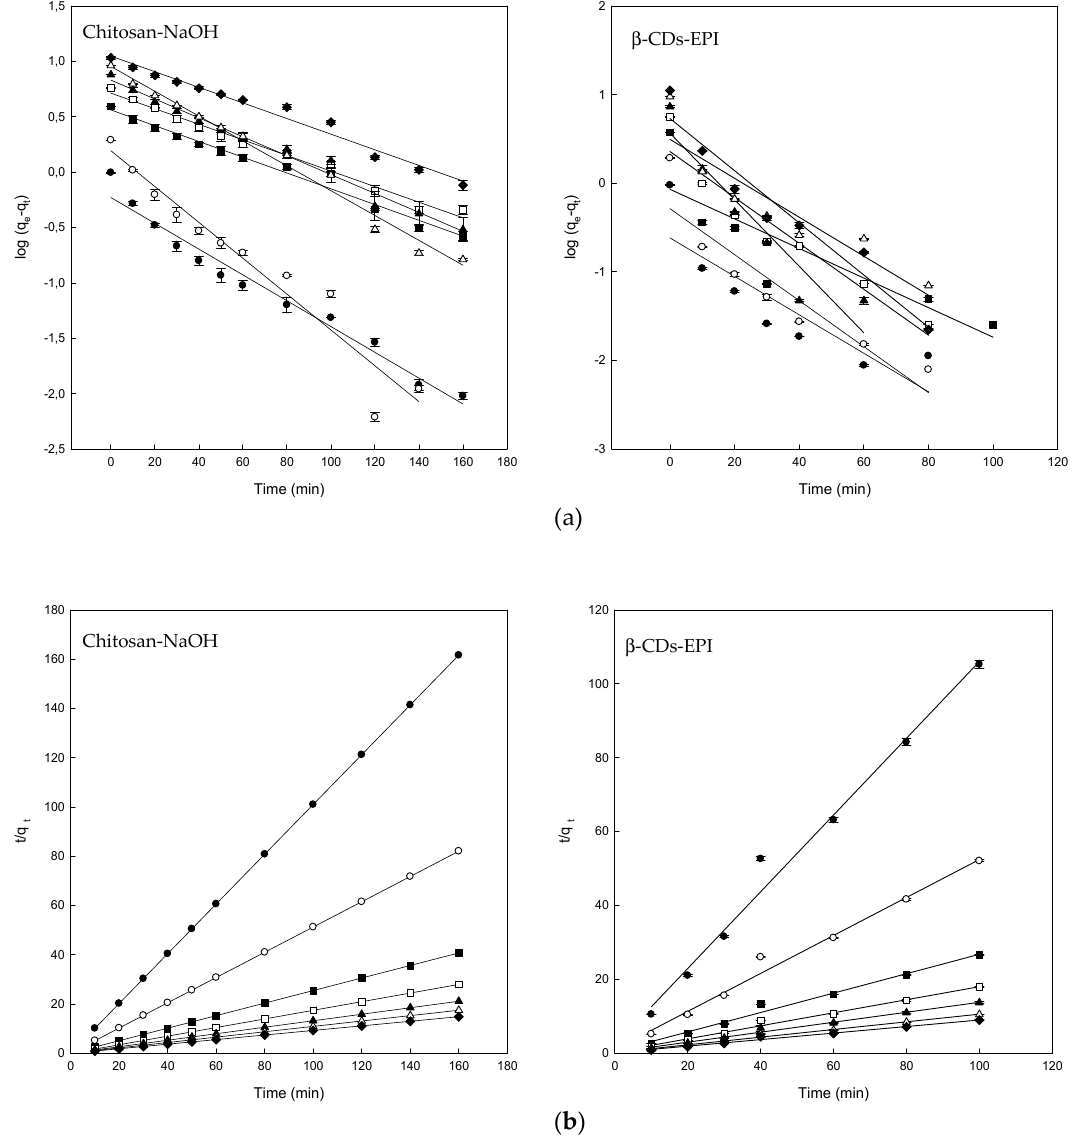
Figure 4. ( a ) The pseudo-first-order model plots and ( b ) pseudo-second-order model plots for the Direct Blue 78 adsorption onto chitosan-NaOH and β -CDs-EPI polymers at di ff erent concentrations of dye 25 mg / L ( (cid:8) ), 50 mg / L ( ), 100 mg / L ( (cid:4) ), 150 mg / L ( (cid:3) ), 200 mg / L ( (cid:78) ), 250 mg / L ( ∆ ) and 300 mg / L ( (cid:7) (cid:35)